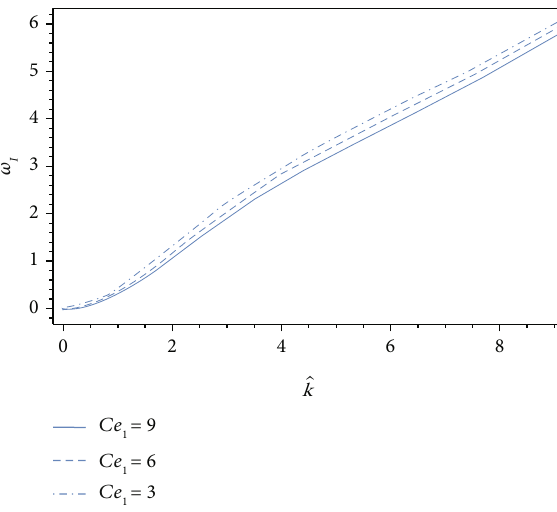
1 on growth rate b β = 0 : 3 , b ε m = 0 : 2 ,